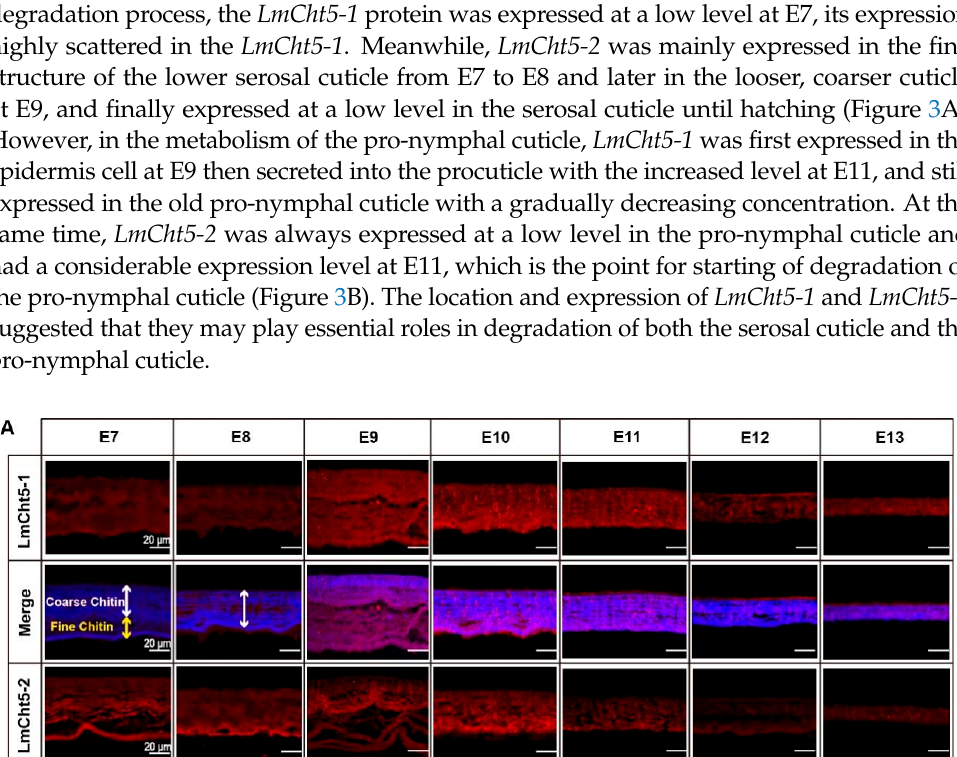
Figure 3. Localization of LmCht5-1 and LmCht5-2 in the degradation of the serosal cuticle and pro- nymphal cuticle. Sections (5 μ m) of eggs from E7 to E13 were visualized with SYTOX ® Green to show the nucleus of cuticle cells (green) and FB28 to counterstain chitin (blue) both in the serosal cuticle ( A ) and the pro-nymphal cuticle ( B ). Localization of LmCht5-1 and LmCht5-2 was previously identified by polyclonal antibody detection with the aid of helper Cy3-AffiniPure donkey anti-rab- bit antibody (red). LmCht5-1 is expressed in a highly scattered way in the coarser upper serosal cuticle at E9, while LmCht5-2 is mainly expressed in the fine structure of the lower serosal cuticle from E7 to E9. During pro-nymphal cuticle degradation, LmCht5-1 is first located in the cuticle cell at E9 and then expressed in the layer structure of the procuticle during E10 to E13, while LmCht5-2 kept a lower expression level in the procuticle degradation process. The white line shows the coarse layer in the upper part, while the yellow line shows the fine layer in the lower part. Pnc: Pro-nym- phal cuticle; NC: first instar nymphal cuticle. 3.5. dsLmCht5-1 and dsLmCht5-2 Inhibited Cuticle Degradation of the Serosal Cuticle in Both Early and Late Embryogenesis of the Locust We then sought to understand the katatrepsis or molting blocking phenotype caused by RNAi of LmCht5-1 and LmCht5-2 , respectively. Paraffin sections of eggs at stage E8 or E13 of ds LmCht5-1 , ds LmCht5-2 , and ds GFP injected groups were prepared for an im- munohistochemistry test (Figures 4A–D and 5A,B). At stage E8, the fine chitin structure on the lower part of the serosal cuticle has been completely hydrolyzed, and the coarse chitin structure on the upper part is in a relaxed state, with comparable expression levels of both LmCht5-1 and LmCht5-2 . Compared to the ds GFP group, the ds LmCht5-1 injection group showed a reduced expression level of LmCht5-1 and a much tighter layer in the